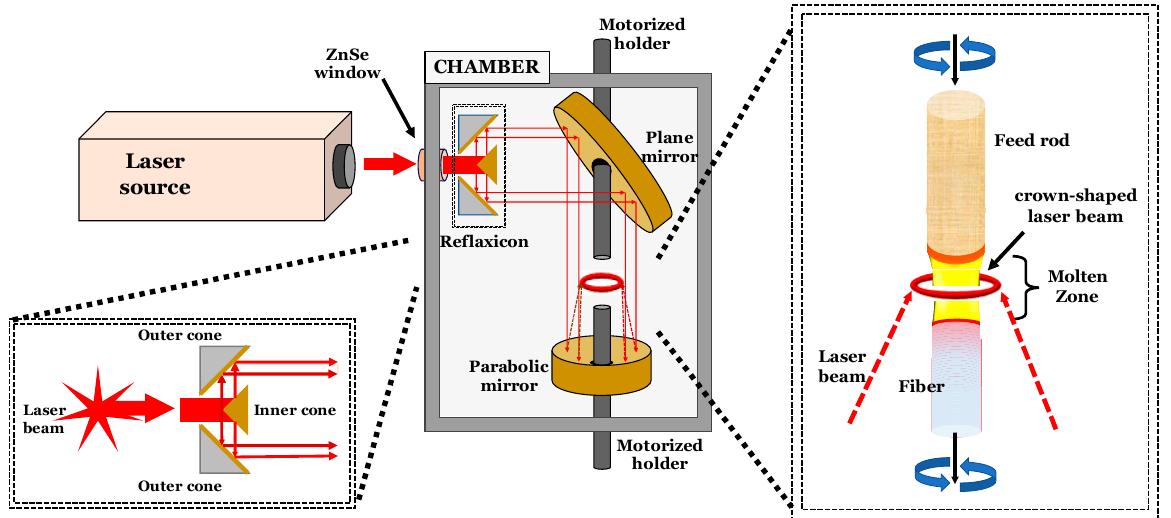
Figure 1. Schematic diagram of the typical Laser Floating Zone (or LHPG) setup, detailing both reflaxicon as molten zone area (see further details in [9,21]).